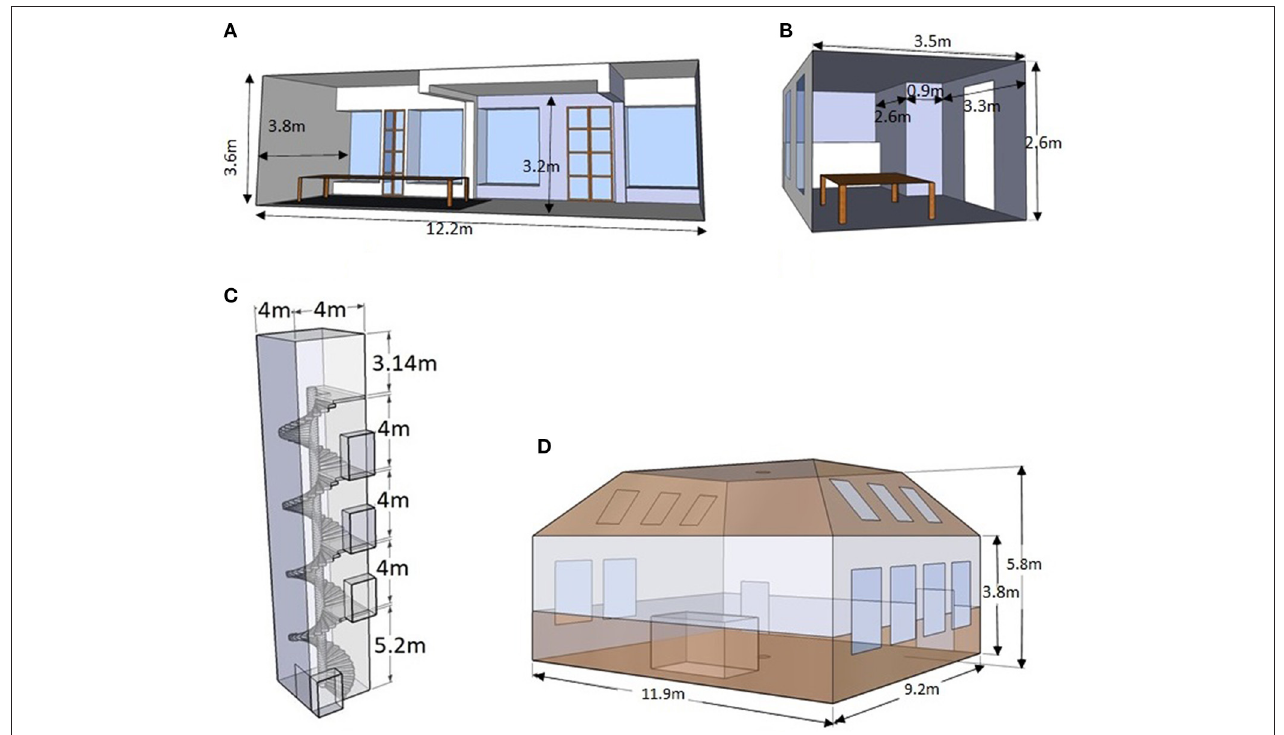
FIGURE 2 | Models and dimensions of the acoustically treated premises: (A) The office of Co-founders, (B) Co-founder meeting room, (C) staircase space, (D) a multifunctional room in the Supreme Court.